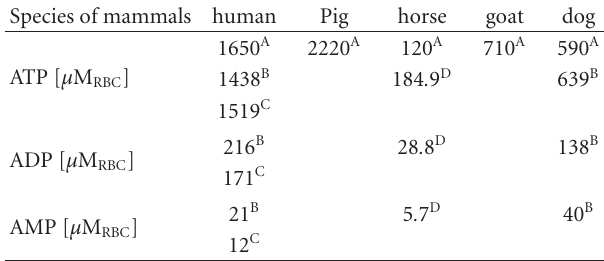
Table 6: Concentration of adenine nucleotides: ATP, ADP, AMP ( µ M ) in erythrocytes of chosen animal species (the own study